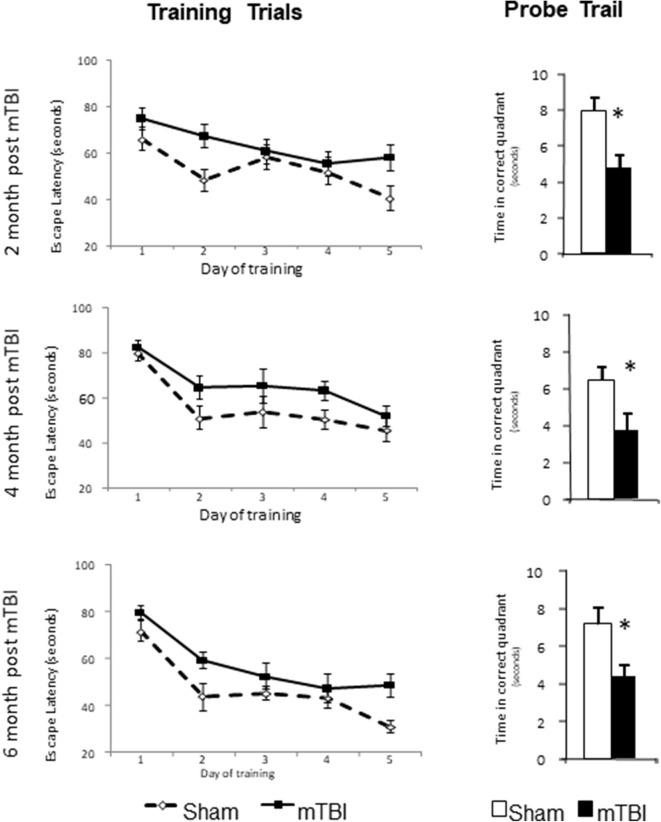
mTBI lead to learning and memory deficits in C57bl/6J mice determined by Morris water maze at 2-, 4-, and 6-month after the injury. Mice had training trail from day 1–5 and probe trail at day 8. Data are mean values ± SE, n = 15 per group. For all leaning trails, Time effect: P < 0.01, TBI effect: P < 0.05, Time X TBI Interaction: >0.05. For all probe trails: *P < 0.05 compared to sham injured mice.